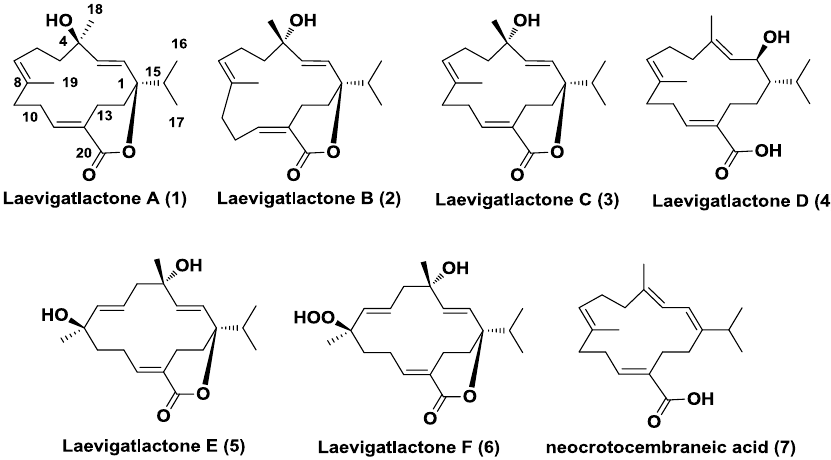
Figure 1. Cembrane diterpenoids were isolated from the leaves of C. laevigatus Vahl.